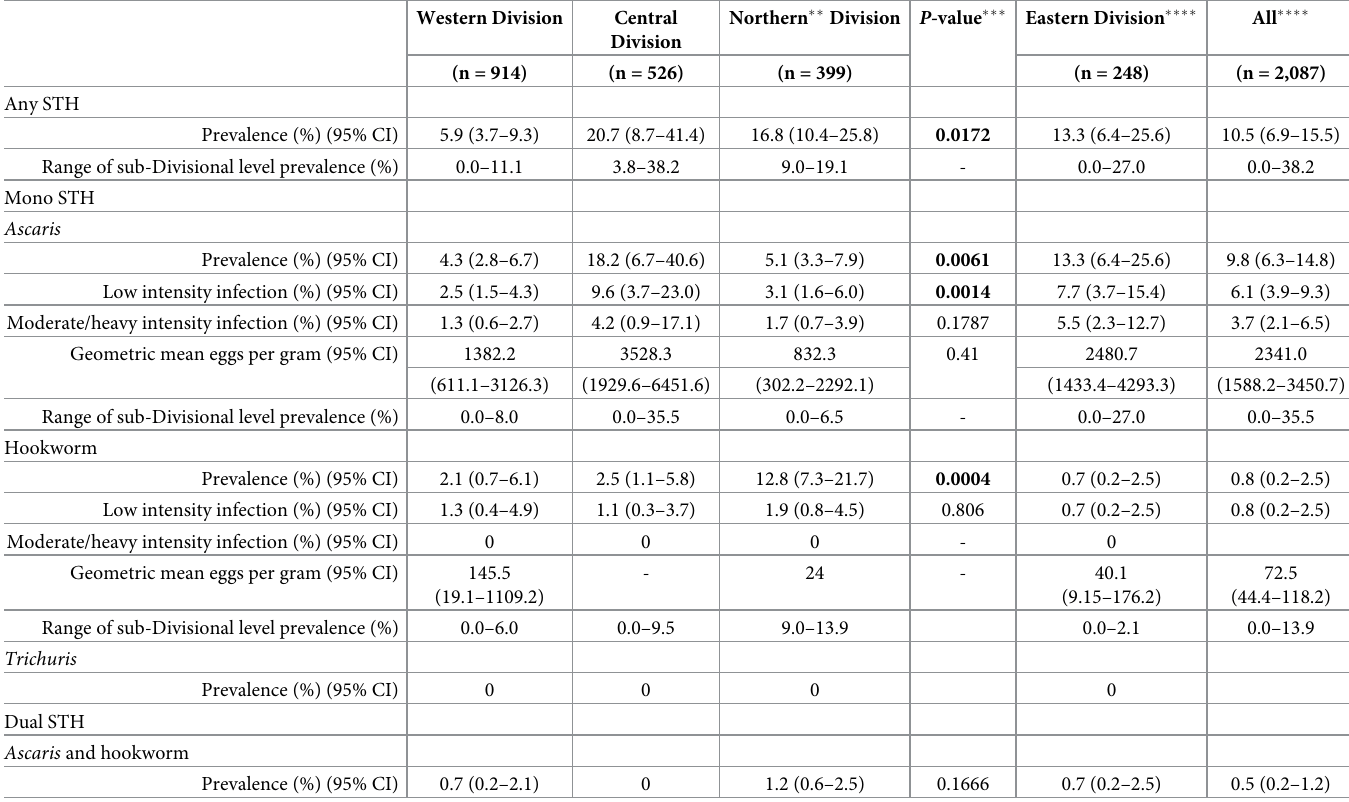
Table 4. Prevalence � and intensity of STH by species among class 1 and 2 students in the 4 Divisions of Fiji,